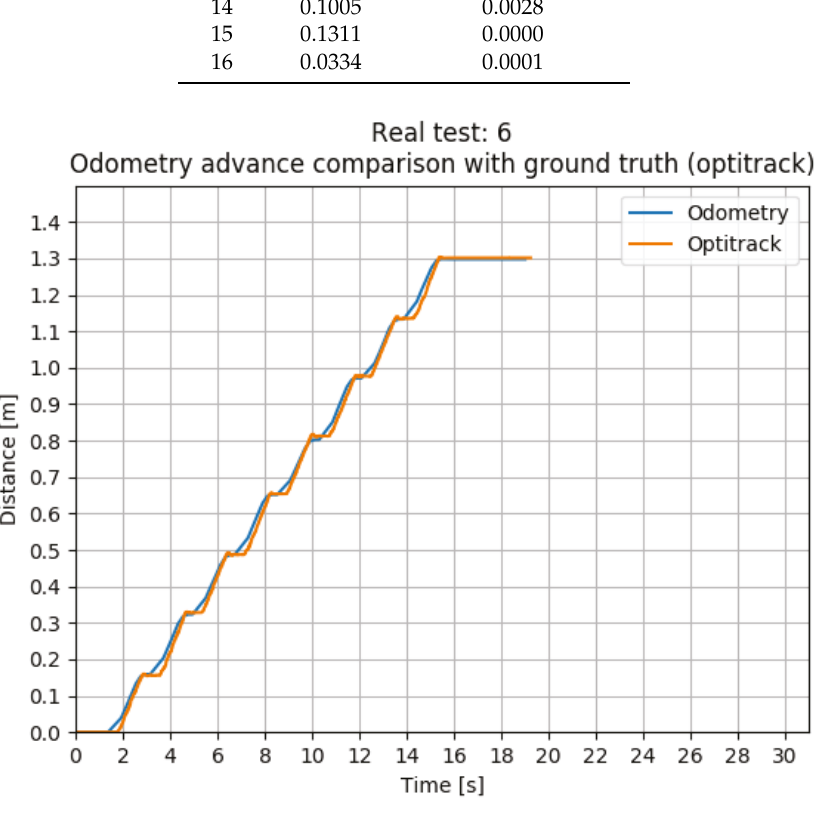
Figure 16. Real test #1.